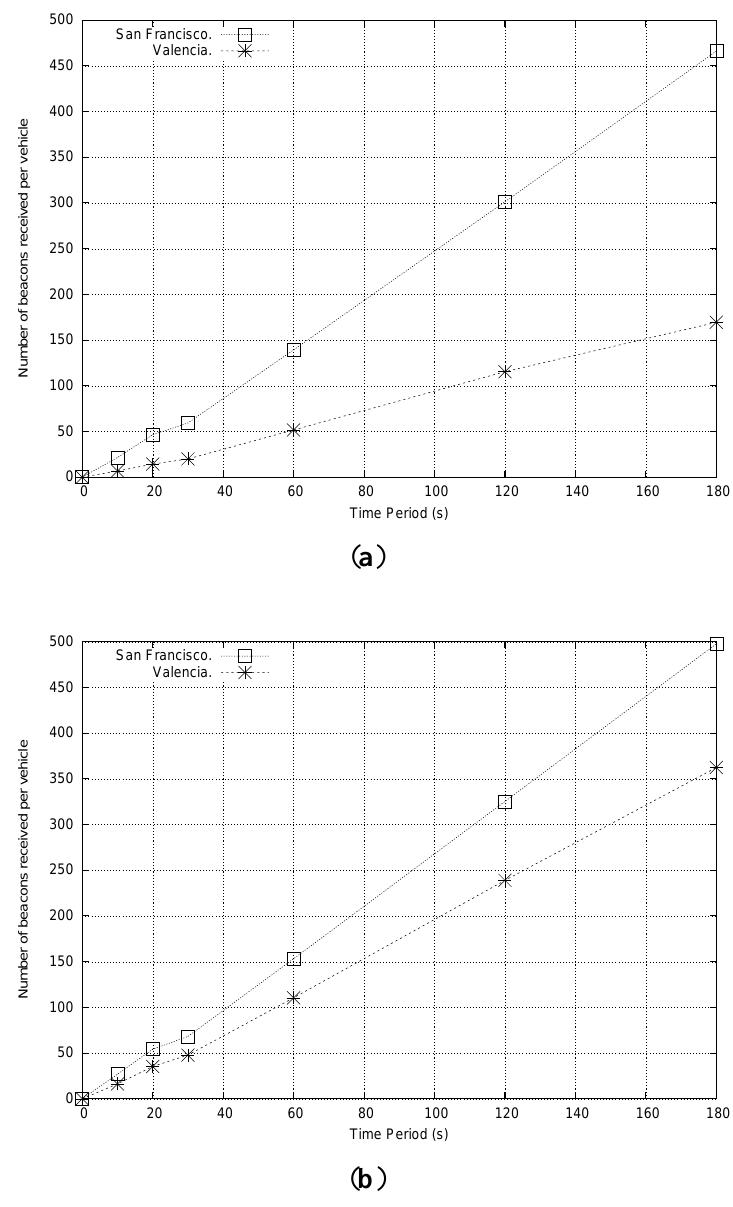
Figure 4. Number of beacons received per vehicle when varying the time period and the city roadmap when simulating: ( a ) 100 vehicles · km − 2 , and ( b ) 200 vehicles · km − 2